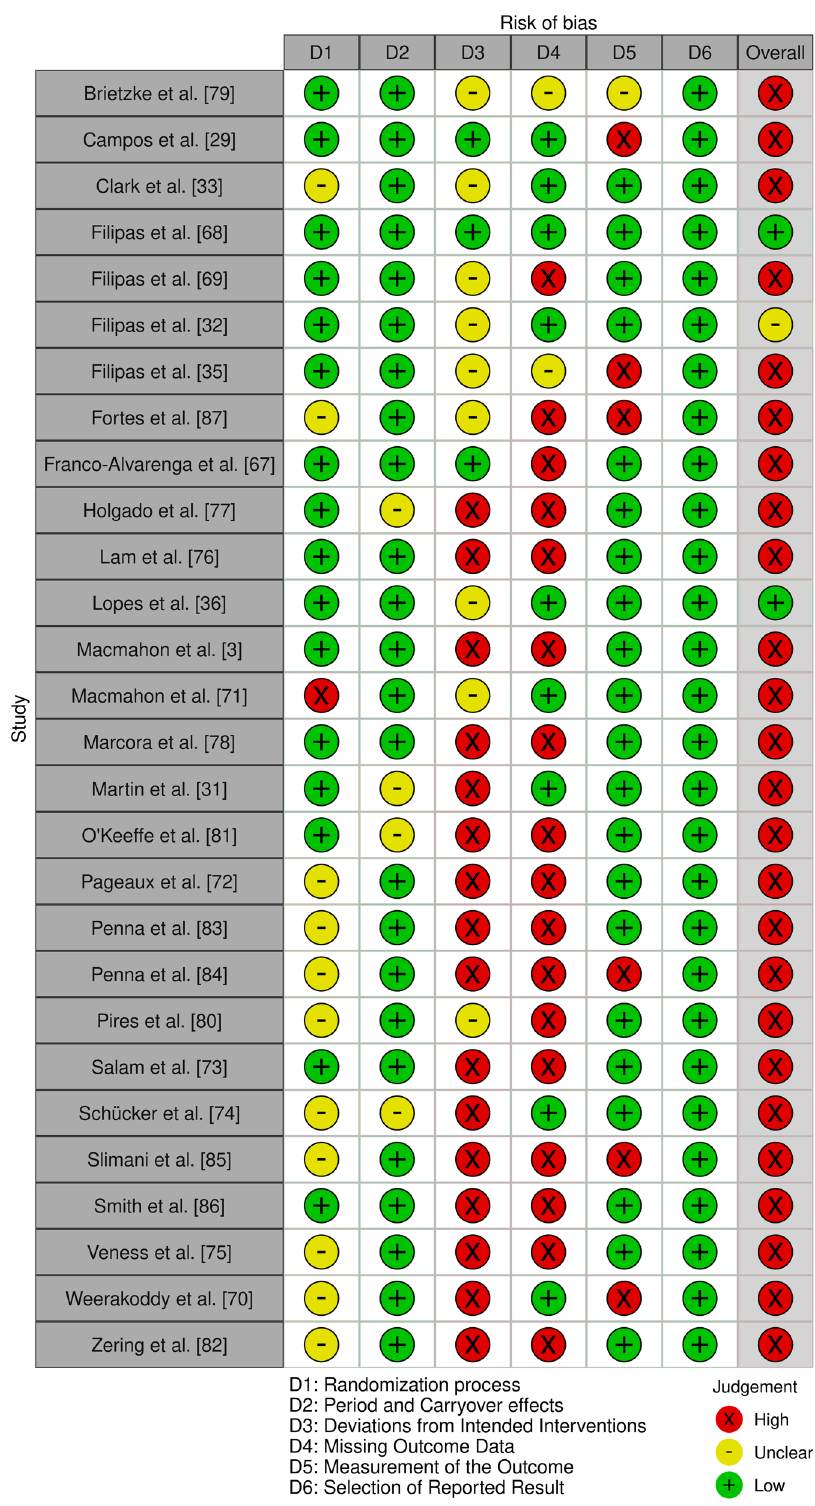
Fig. 3 Risk of bias within